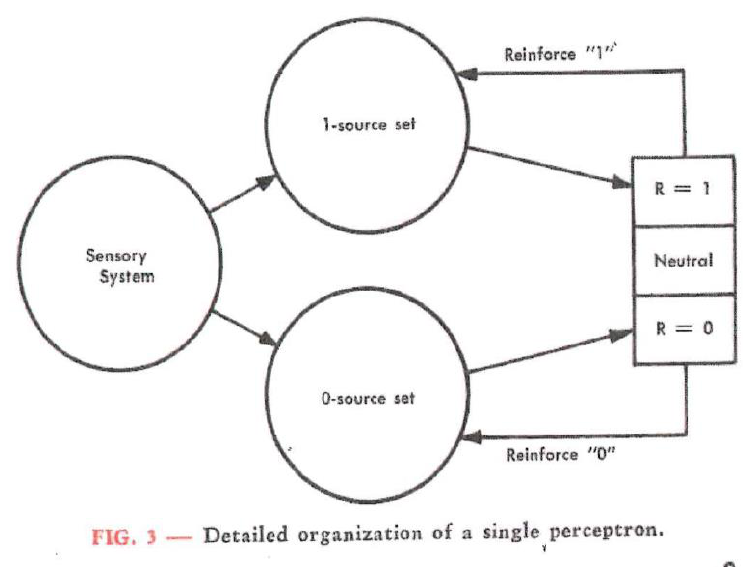
Figure 6. Detailed organization of a single perceptron [16] (p. 3).